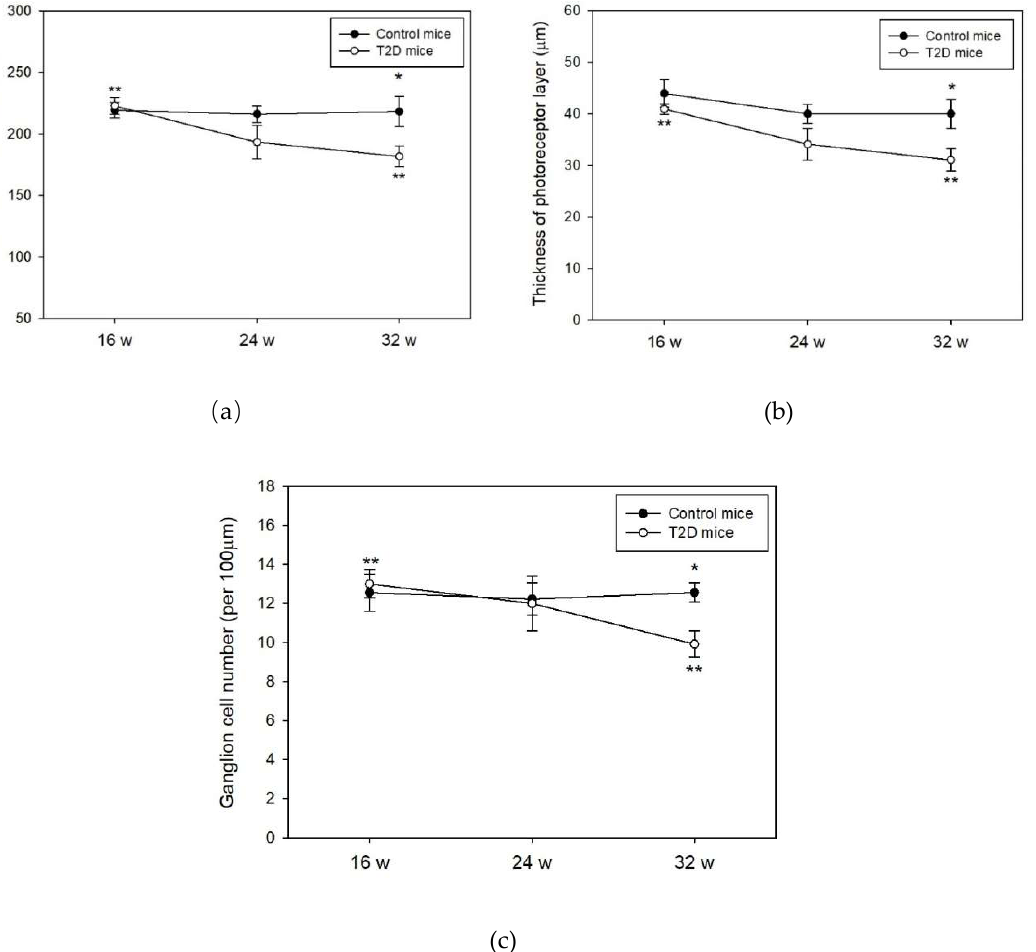
Figure 2. Histological evaluation of the mice retina at 16, 24, and 32 weeks (w) of age. Data